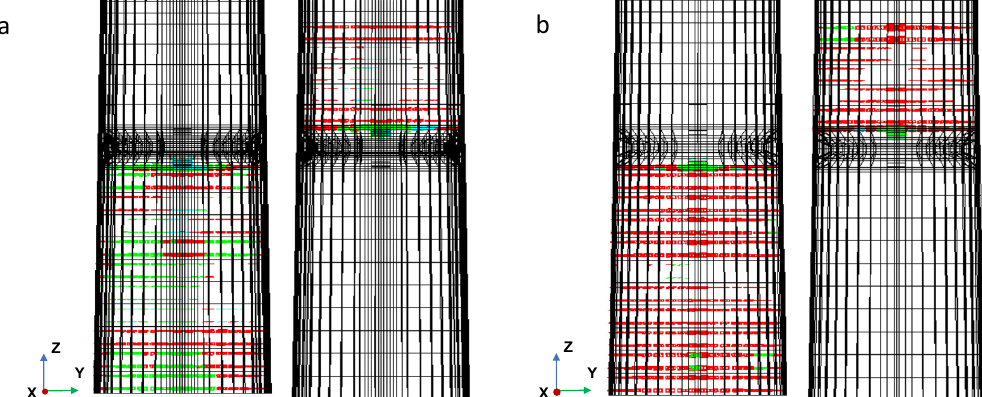
Figure 14. Crack pattern for concrete ‐ concrete (a) non ‐ planar, and (b) planar, contact conditions (crack status: opening in red colour; closing in green colour, reopening in cyan colour). Table 5. Analysis for assessing the influence on the tower’s behaviour of the friction angle and normal stiffness of the concrete ‐ concrete contact.